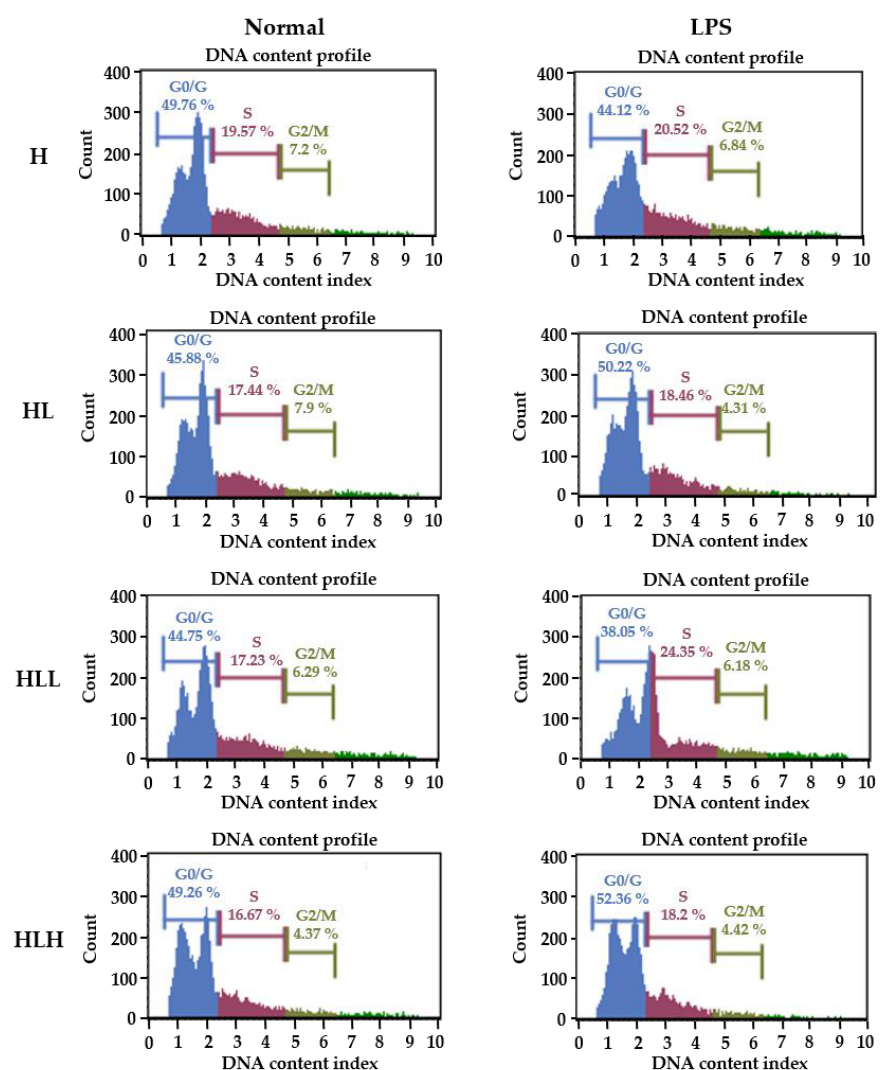
Figure 6. Effect of B lymphocyte activation of splenocytes. The mice were fed a HFD alone for 23 days. They were then administered 150 mg/kg and 300 mg/kg LL for the next 20 days daily along with an HFD. The mice were administered 5 mg/kg of LPS i.p. followed by sacrifice after 1hr. The spleens were isolated, and the splenocytes were isolated using a cell strainer and stimulated with 10 µ g/mL of LPS for 72 h, and fixed with 70% ethanol. The cells were stained for the cell cycle and analyzed using the Muse Cell analyzer. H, HFD diet; HL, HFD diet + LPS; HLL, HFD + LPS + 150 mg/kg LL; HLH, HFD + LPS + 300 Table 3. Percentage cell counts in a different phase of the cell cycle.